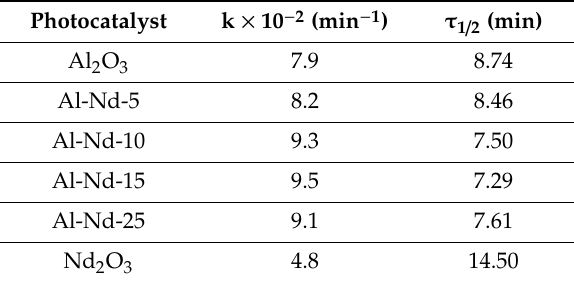
Table 2. Rate constant (k) and half-life time ( τ 1/2 ) in the diclofenac photo-degradation reaction using Al 2 O 3 -Nd 2 O 3 binary oxides.